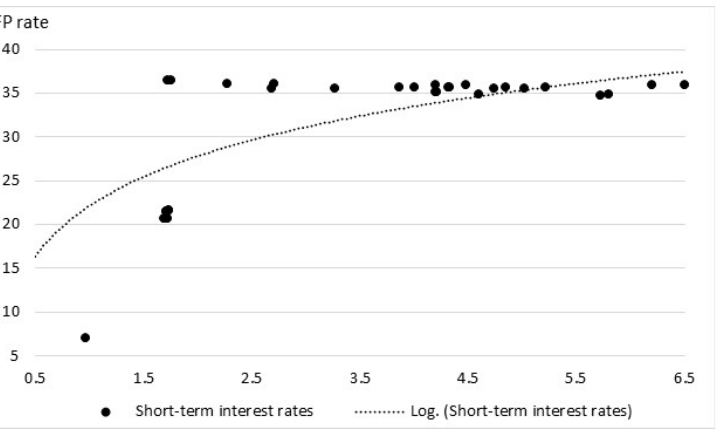
Figure 5. Relationship between fuel poverty rate and short ‐ term interest rate in Poland in 2004–mid ‐ 2021.